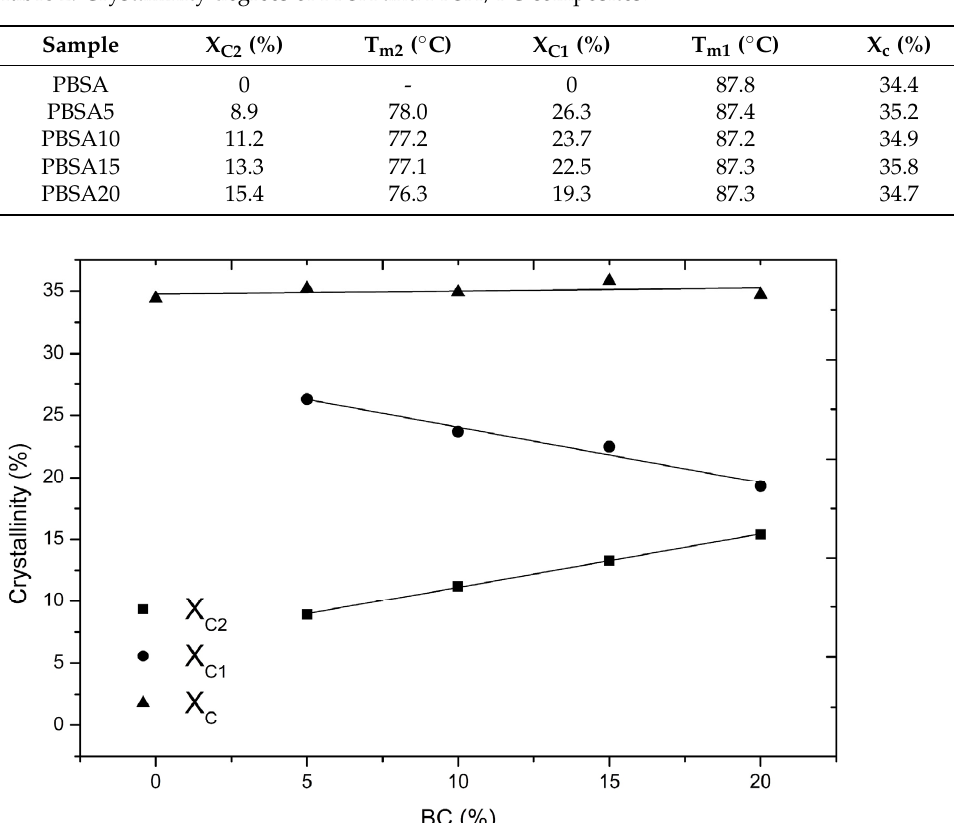
Table 2. Crystallinity degrees of PBSA and PBSA/BC composites.